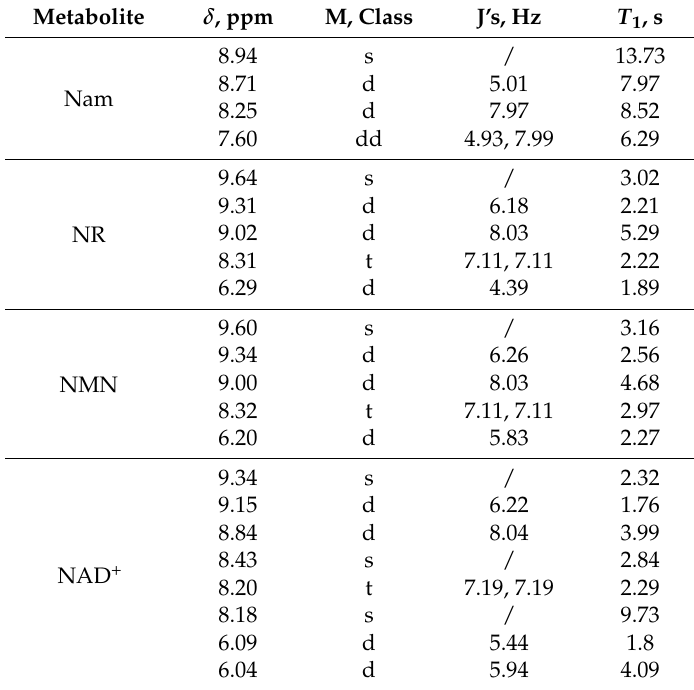
Table 1. Proton nuclear magnetic resonance ( 1 H NMR) spectral parameters of NAD and its major